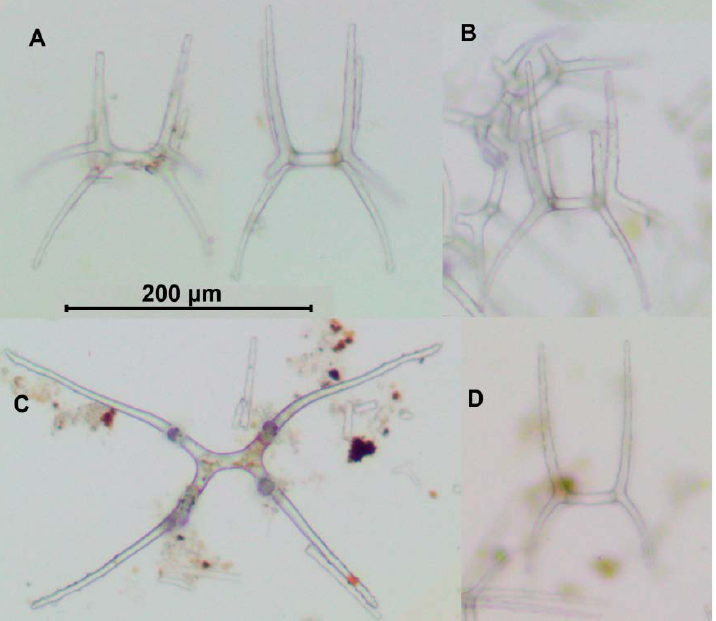
Figure 7. Peniagone saveljevae sp. nov., paratype: ( A , B ) dorsal ossicles; ( C , D ) ventral ossicles. Holotype . Specimen 60 mm, RV Akademik M.A. Lavrentiev , cruise 71 (SokhoBio), St. 01- 11, 11.07.2015, Agassiz Trawl, 46°09.047′ – 46°08.738′ N, 146°00.789′ – 145°59.512′ E, 3305 – 3304 m. The specimen will be deposited at MIMB, currently stored at IORAS, Cat. Nr